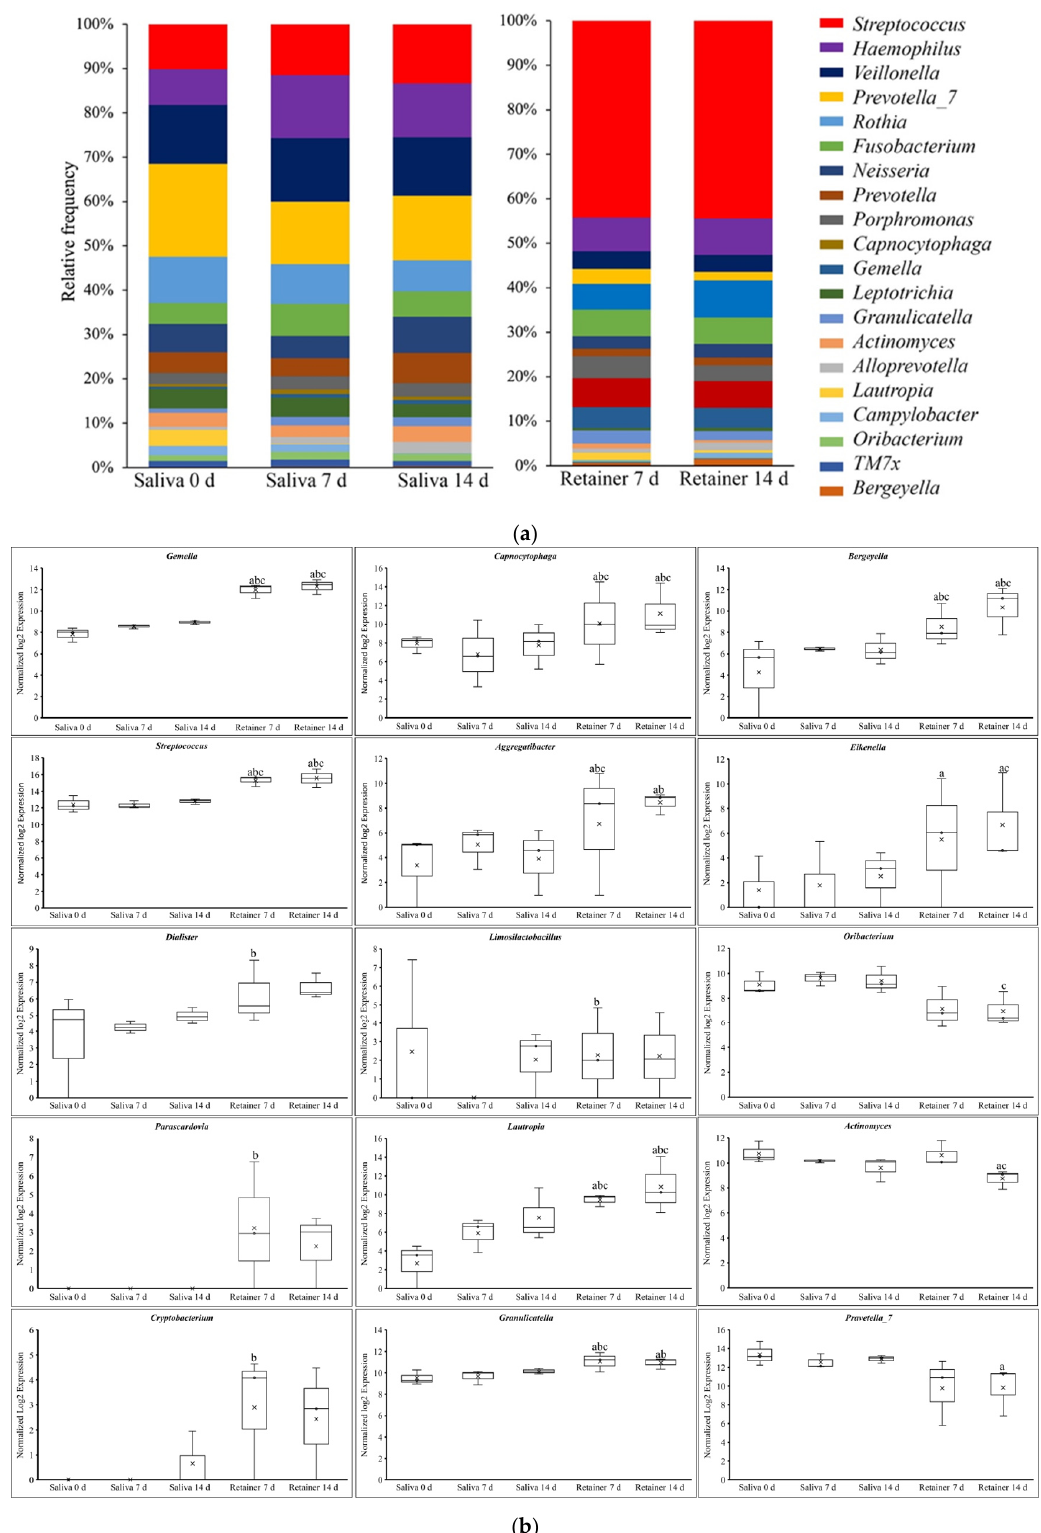
Figure 4. Analyses of the changes in microbial structure at the genus level. ( a ) The distributions of predominant oral microbial taxa (relative frequency) at the genus level in saliva and retainer, with each color representing one genus. ( b ) Comparison of oral microbiota normalized log2 fold changes at the genus level in saliva and clear retainer after 7 and 14 days. a: Compared to salivary bacteria at 0 days. b: Compared to salivary bacteria at 7 days. c: Compared to salivary bacteria at 14